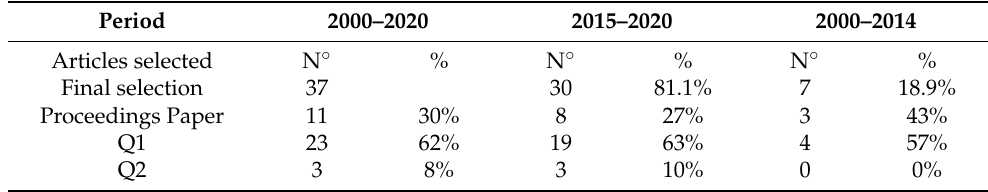
Table 2. Main data associated with the quality of the scientific journals in which the selected articles have been